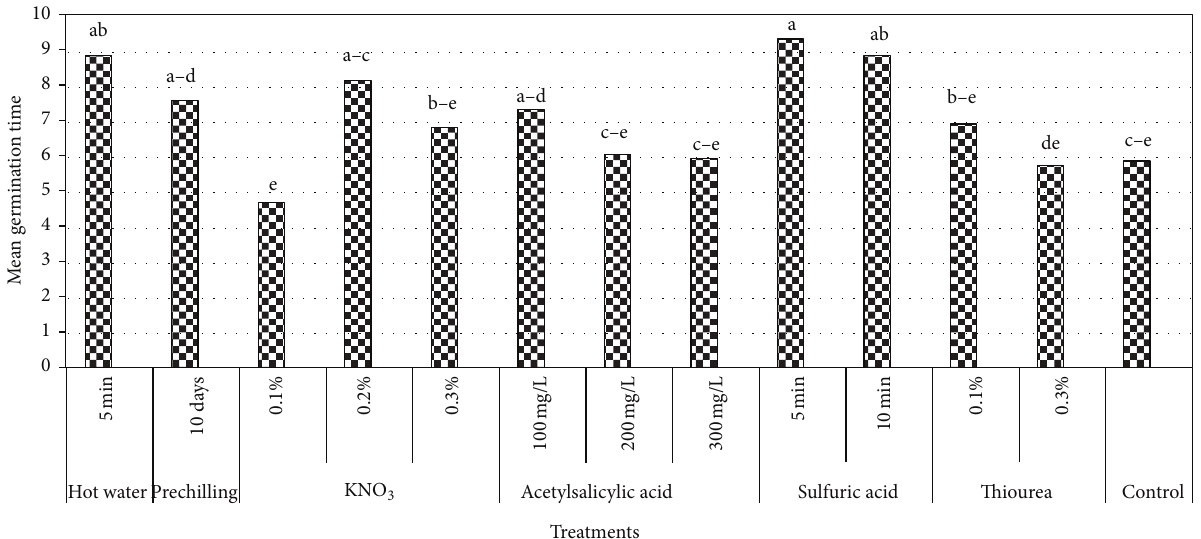
Figure 3: Comparison effects of various treatments on mean germination time of C. persica